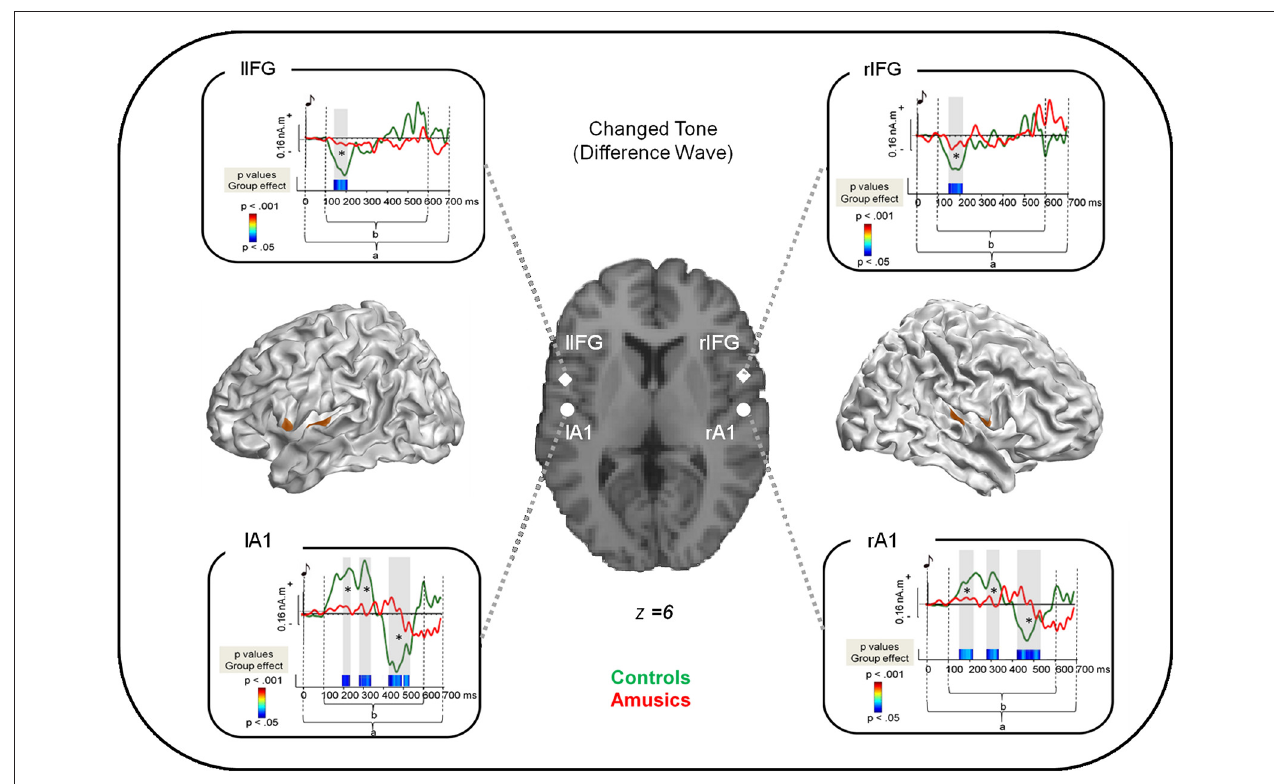
performed (0–700 ms after the changed tone onset, as indicated by a) for the control group (green) and the amusic group (red). Two sample t -tests were performed at each time sample and for each region on source amplitude in the 100–600 ms time window (as indicated by b) in the two groups of participants. p -values are reported across time below the source amplitudes with blue for p < 0.05; green for p < 0.01; and red for p < 0.001. Note that only effects lasting longer than 15 ms were reported. See Albouy et al., 2013a for